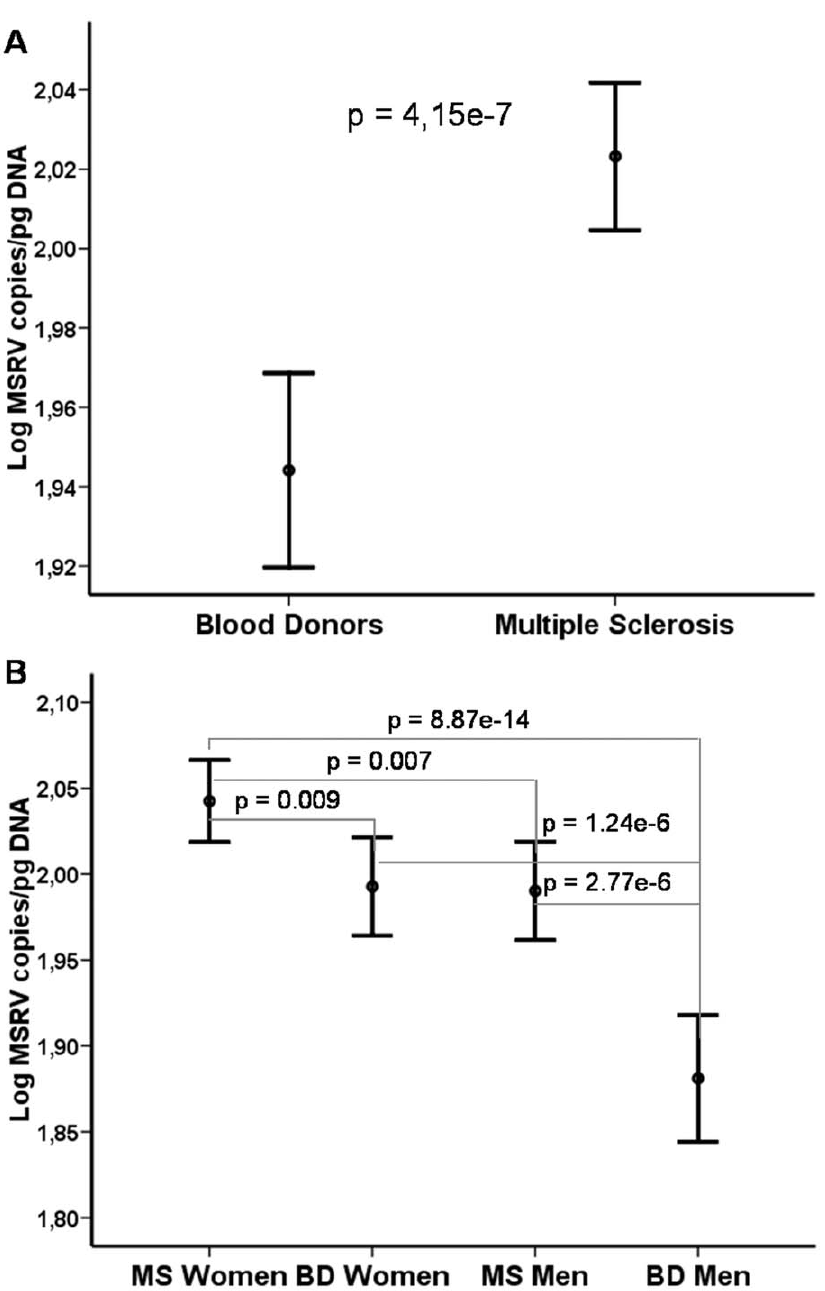
Figure 1. MSRV DNA load MS diagnosis and sex. A) MSRV DNA load is more elevated in PBMC of MS patients (n=178) than in controls (n=124) (ANOVA; p=4.15e-7). B ) MSRV DNA load is more elevated in MS women (n=112) than in control women (n=70) (ANOVA; p=0.009), control men (n=54) (ANOVA; p=8.87e-14) and MS men (n=66) (ANOVA; p=0.007). MSRV DNA load is more elevated in control women (n=70) than in control men (n=54) (ANOVA; p=1.24e-6). Points represent the mean and bars represent 95% Confidence Interval of Mean. MSRV DNA load represents MSRV copies/pg of DNA.